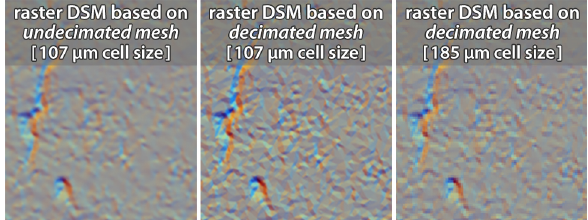
Figure 8 . A raster DSM derived from an undecimated polymesh (left) versus its auto-decimated version (centre and right). The latter two rasters have cell sizes that correspond to the image GSD and the size proposed by Metashape,